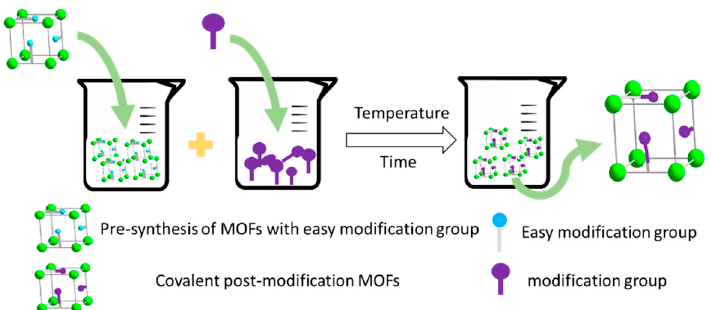
Figure 6. Schematic diagram for the covalent post-synthetic modification of MOFs.